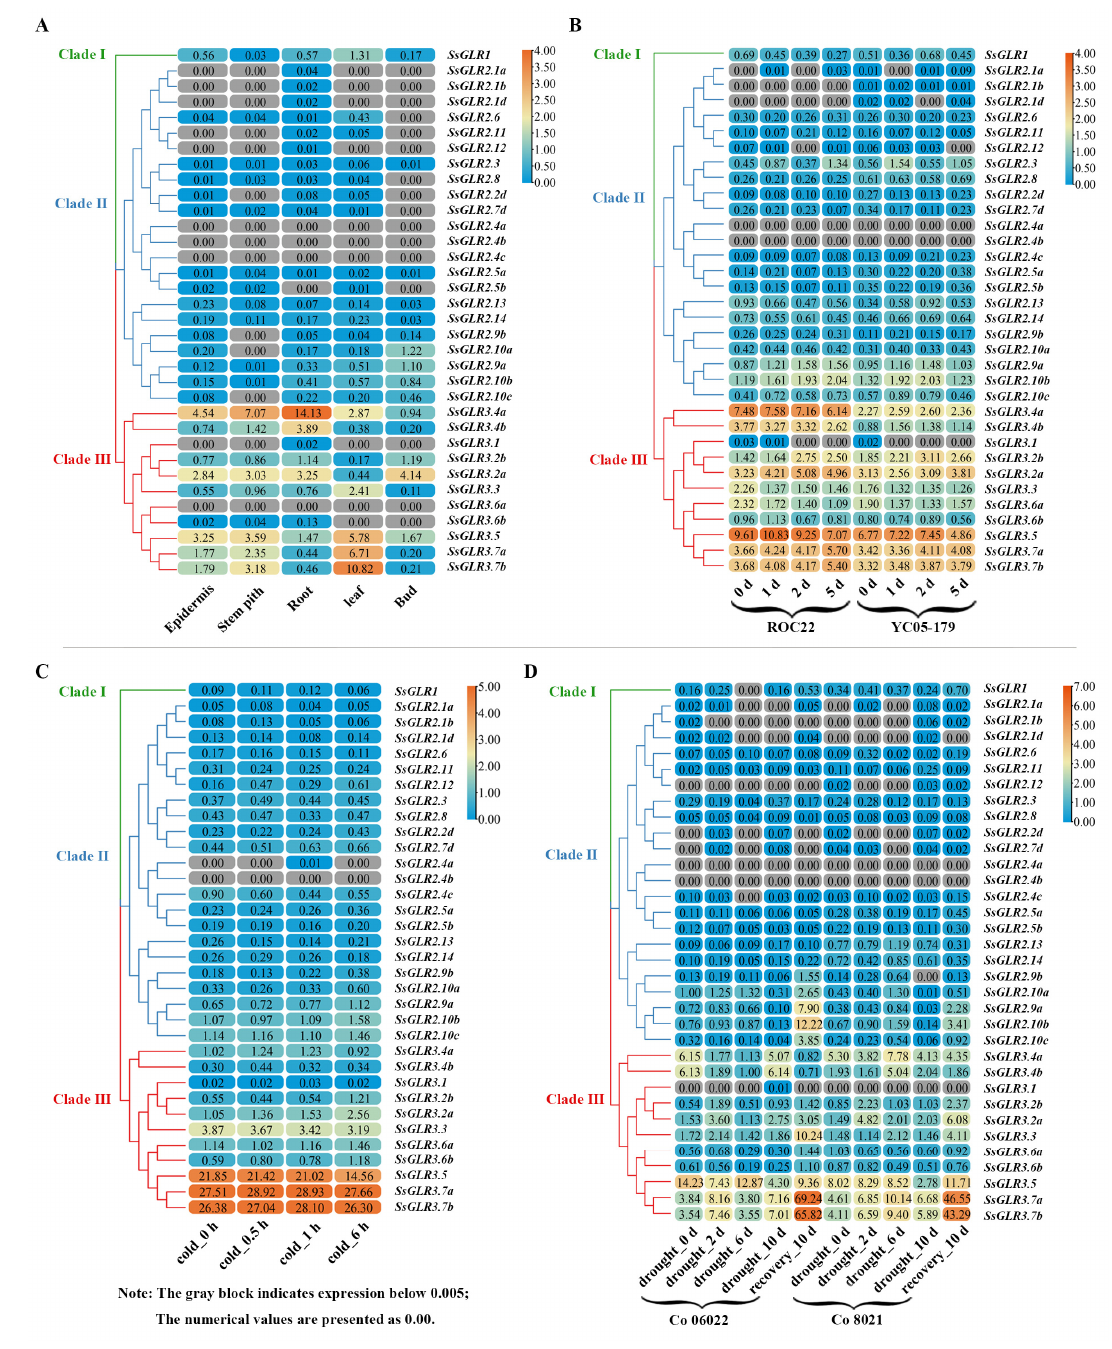
Figure 7. Expression patterns of the sugarcane GLR genes from the sugarcane transcriptome data in four different conditions. ( A ) Expression patterns of the SsGLR genes in different tissues of ten-month-old sugarcane cultivar ROC22. ( B ) Expression patterns of the SsGLR genes in ROC22 (susceptible cultivar) and YC05-179 (resistant cultivar) after smut pathogen infection at 0, 1, 2, and 5 d. ( C ) Expression patterns of the SsGLR genes under cold stress. ( D ) Expression patterns of the SsGLR genes in Co 06022 (susceptible cultivar) and Co 8021 (resistant cultivar) after 0, 2, 6, and 10 d drought stress and recovery treatment. The color code on the right side of the figure was constructed by TBtools (64 bit), with the transcript level of the SsGLR genes transformed as log 2 FPKM (fragments per kilobase million), ranging from blue (low expression level) to orange (high expression level). The number on the box represented the FPKM value.